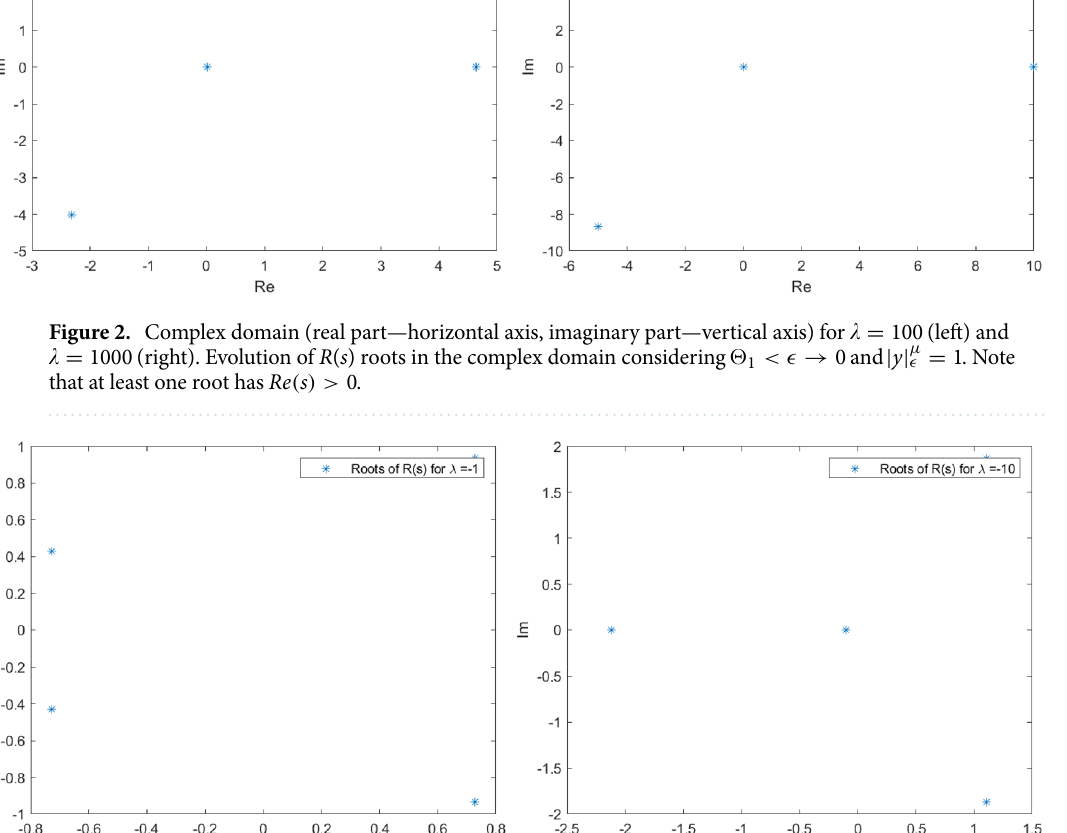
Figure 3. Complex domain (real part—horizontal axis, imaginary part—vertical axis) for (cid:31) = − 1 (left) and (cid:31) = − 10 (right). Evolution of R ( s ) roots in the complex domain considering � 1 < ǫ → 0 and | y | µ that at least one root has Re ( s ) > 0